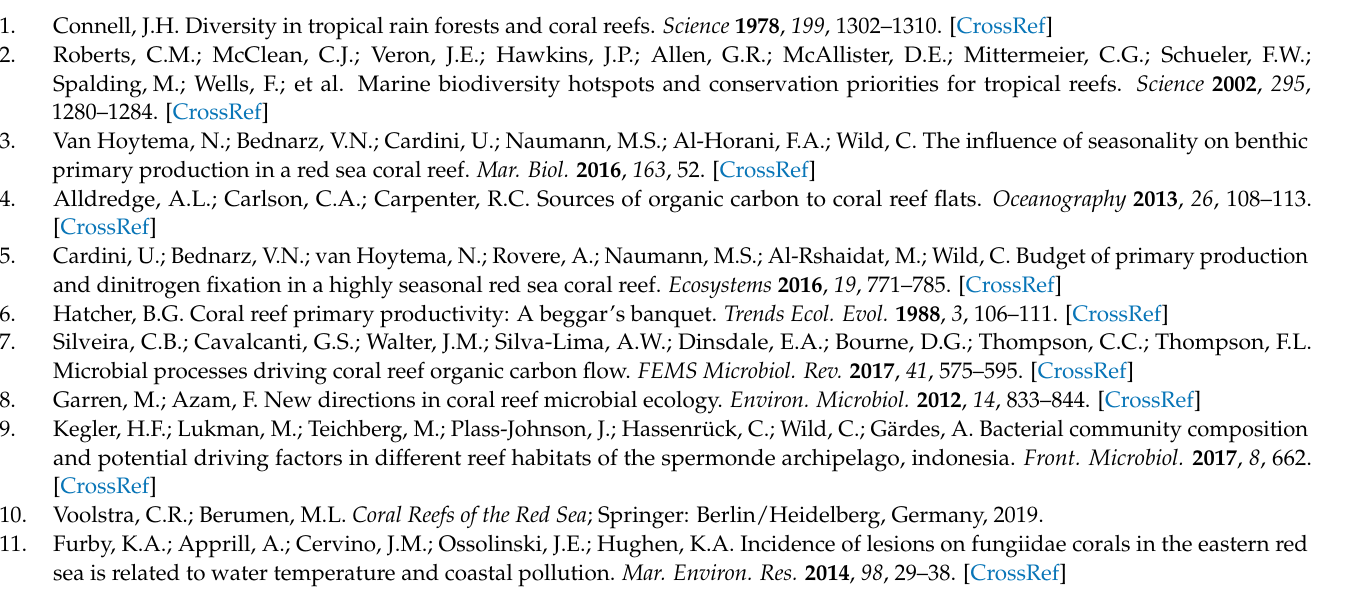
Figure S3: Composition of bacterial and carbon-fixation microbial community; Table S1: Correlation of environmental variables with bacterial OTU abundance determined by partial Mantel tests; Table S2: Correlation of environmental variables with cbbL gene OTU abundance determined by partial Mantel tests; Table S3: Correlation of key 16S rRNA gene OTUs with cbbL gene clusters in surface water; Table S4: Correlation of key 16S rRNA gene OTUs with cbbL gene clusters in bottom water; Table S5: Correlation of environmental variables with β NTI values of bacterial community determined by partial Mantel tests; Table S6: Correlation of environmental variables with β NTI values of carbon- fixation microbial community determined by partial Mantel tests; Table S7: Environmental characters of all sampling